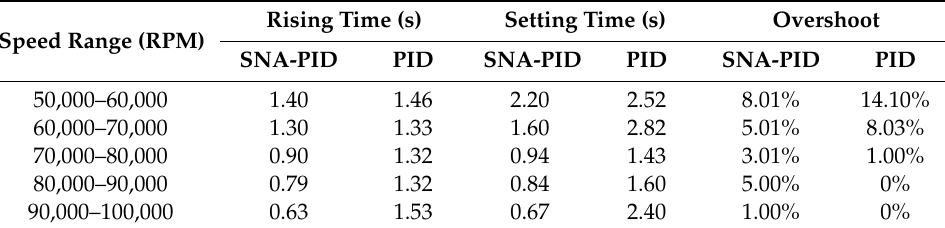
Table 5. Performance comparisons for Case I.